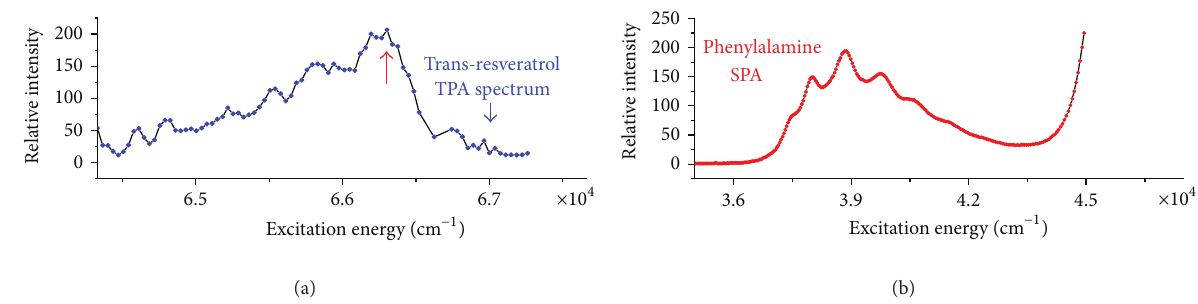
F 5: Comparison between the TPA of tr and the SPA of phenylalanine. (a) Two photon absorption spectrum of the tr over the excitation energy range relevant to the present work. Adapted from [23]. e blue arrow at the top right marks the two-photon excitation yield under the nonresonant conditions, that is, when the relative two-photon cross-section is negligible. e red arrow pointing to the maximum of the spectrum refers to the so-called resonant conditions. (b) Single-photon absorption of the phenylalamine adapted from [35]. Notice how by comparing both -axis values, the energy employed in any of the two laser excitation conditions is good enough to excite electronically, by energy transfer, the phenylalamine. See text for 𝑥𝑥